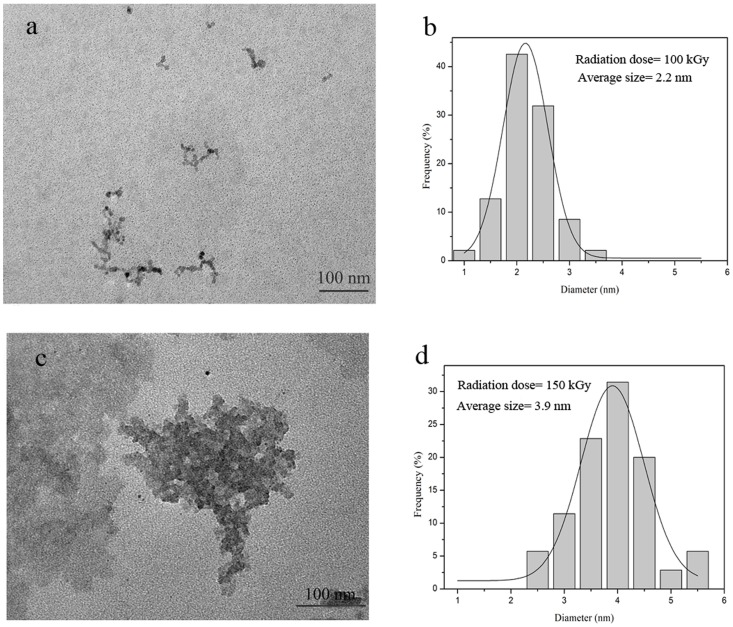
TEM images and size distributions of Fe3O4 nanoparticles synthesized at: a, b) 100 kGy, with average size of 2.2 nm, and c, d) 150 kGy, with average size of 3.9 nm.